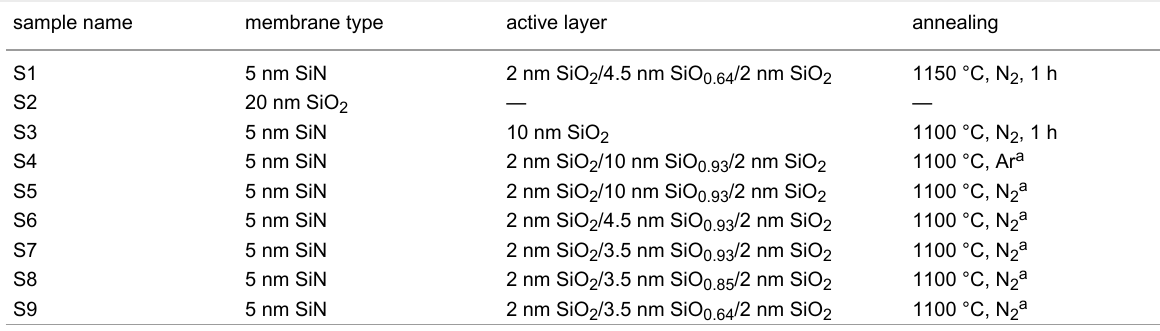
Table 1: List of TEM membrane samples fabricated within this